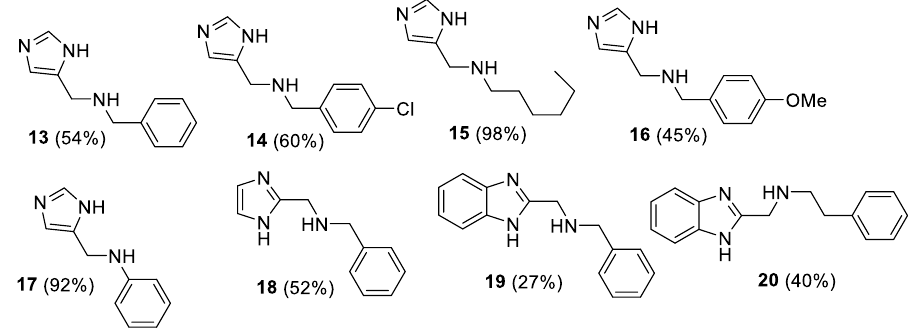
Figure 2. Synthesized imidazole N -substituted methanamines.